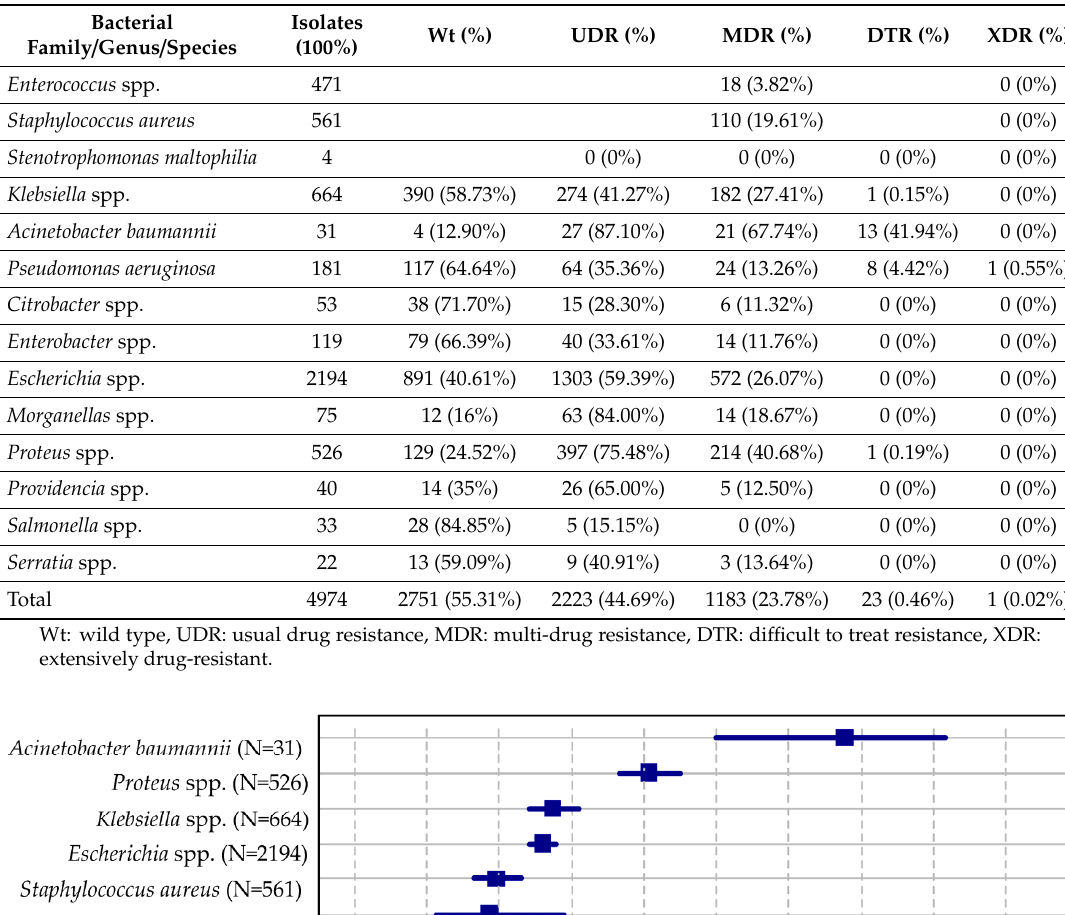
Table 3. Antibiotic resistance levels of ESKAPE isolates during the study period.